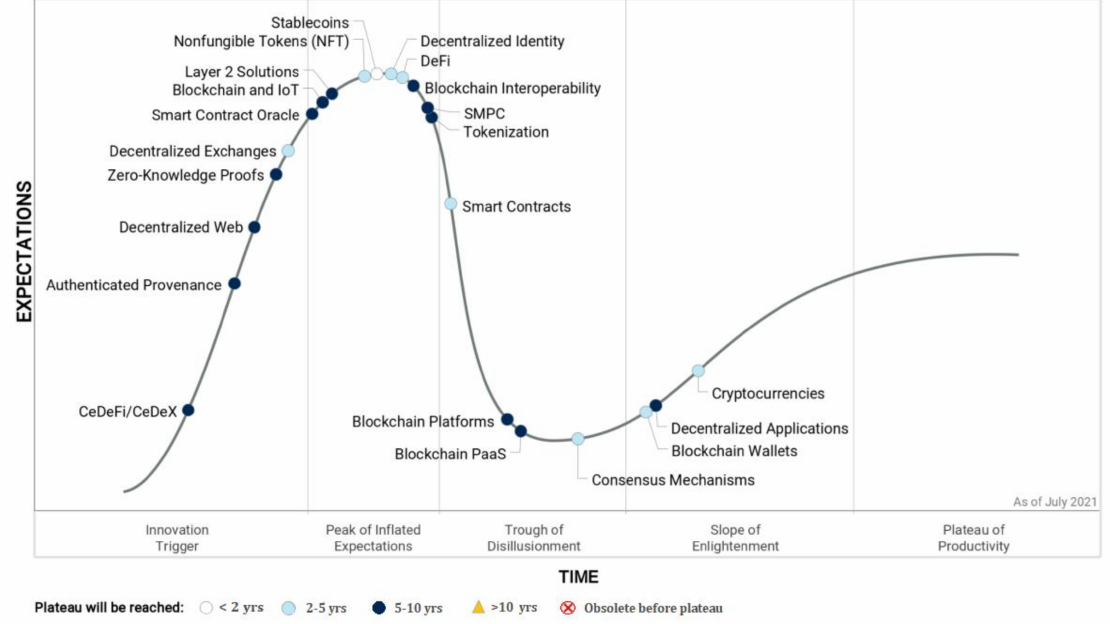
Figure 8. Gartner hypecycle for